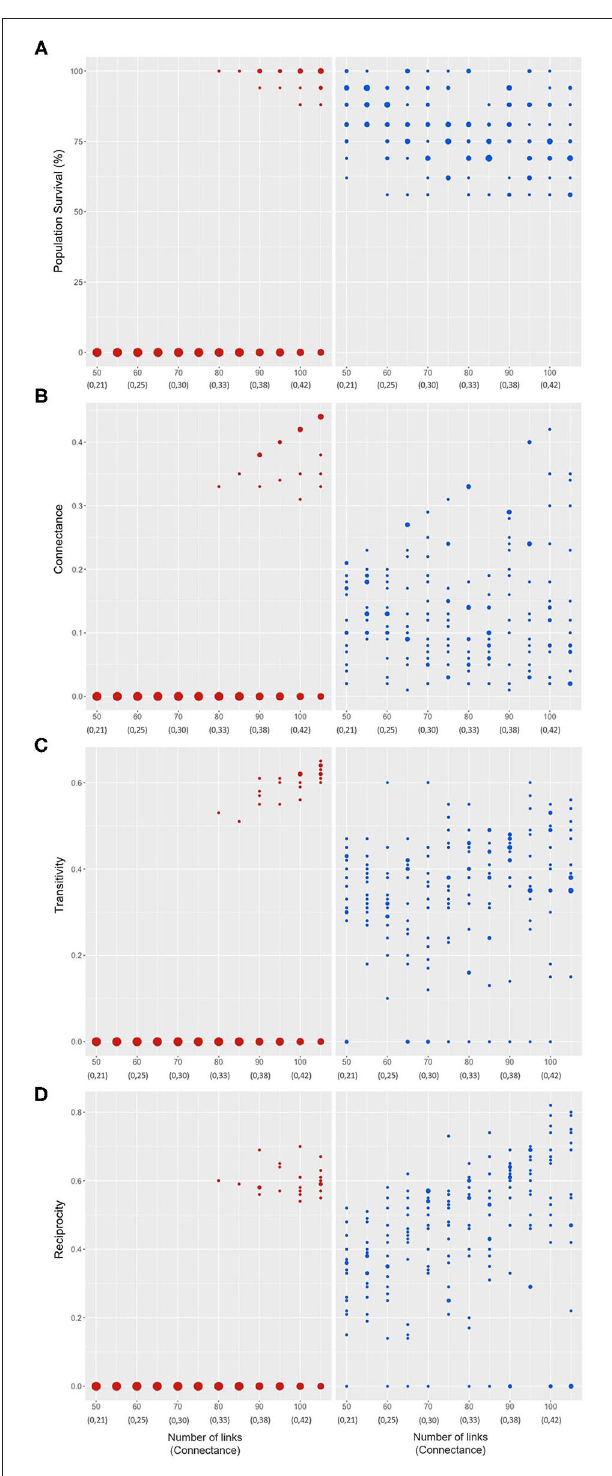
FIGURE 6 | Final networks properties as a function of the number of links of the initial networks (corresponding connectance value below) after experiments. Percentage of survival of populations (A) , Connectance (B) , Transitivity (C) , Reciprocity (D) . Left column: link up path (red dots); right column: link down path (blue dots). The size of the dots represent the proportion of times that a result (of the 40 repetitions) yields a given